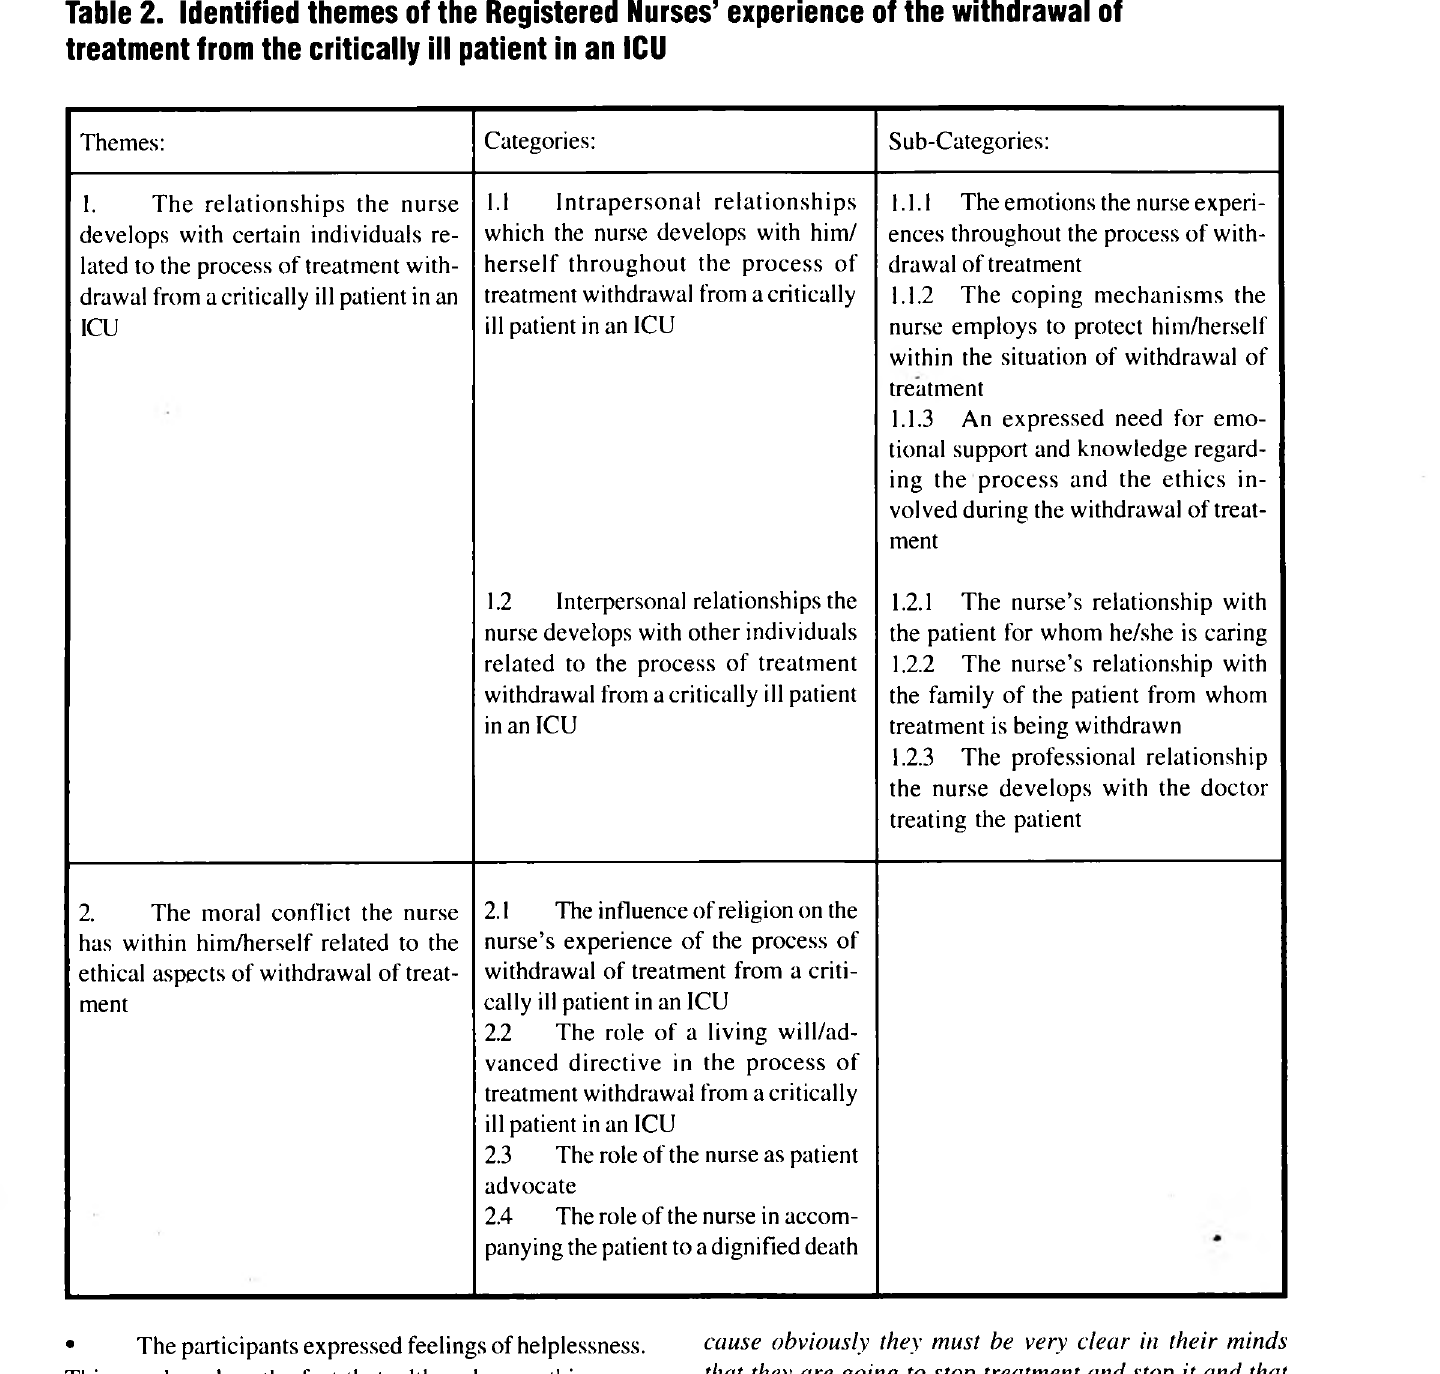
Table 2. Identified themes of the Registered Nurses’ experience of the withdrawal of treatment from the critically ill patient in an